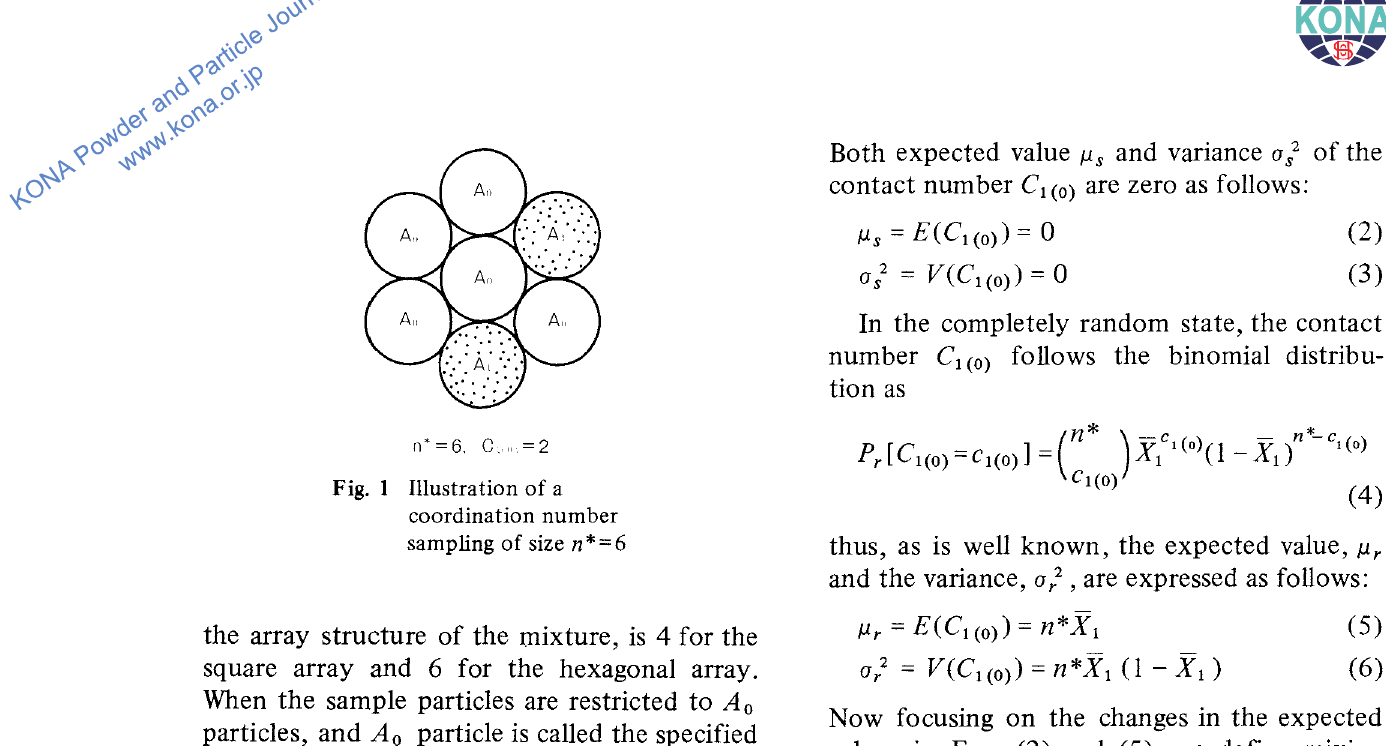
Fig. 1 Illustration of a coordination number sampling of size n*=6